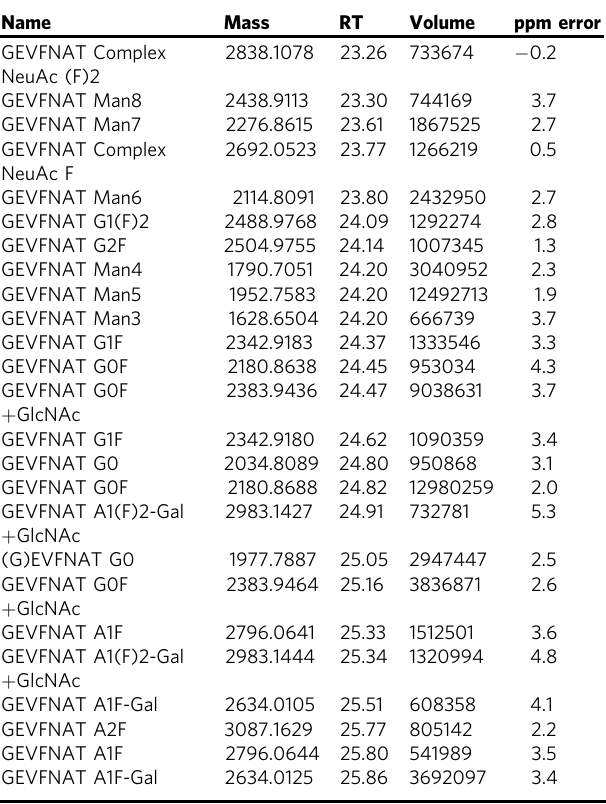
Table. 1 Accurate masses and retention times for GEVFNAT